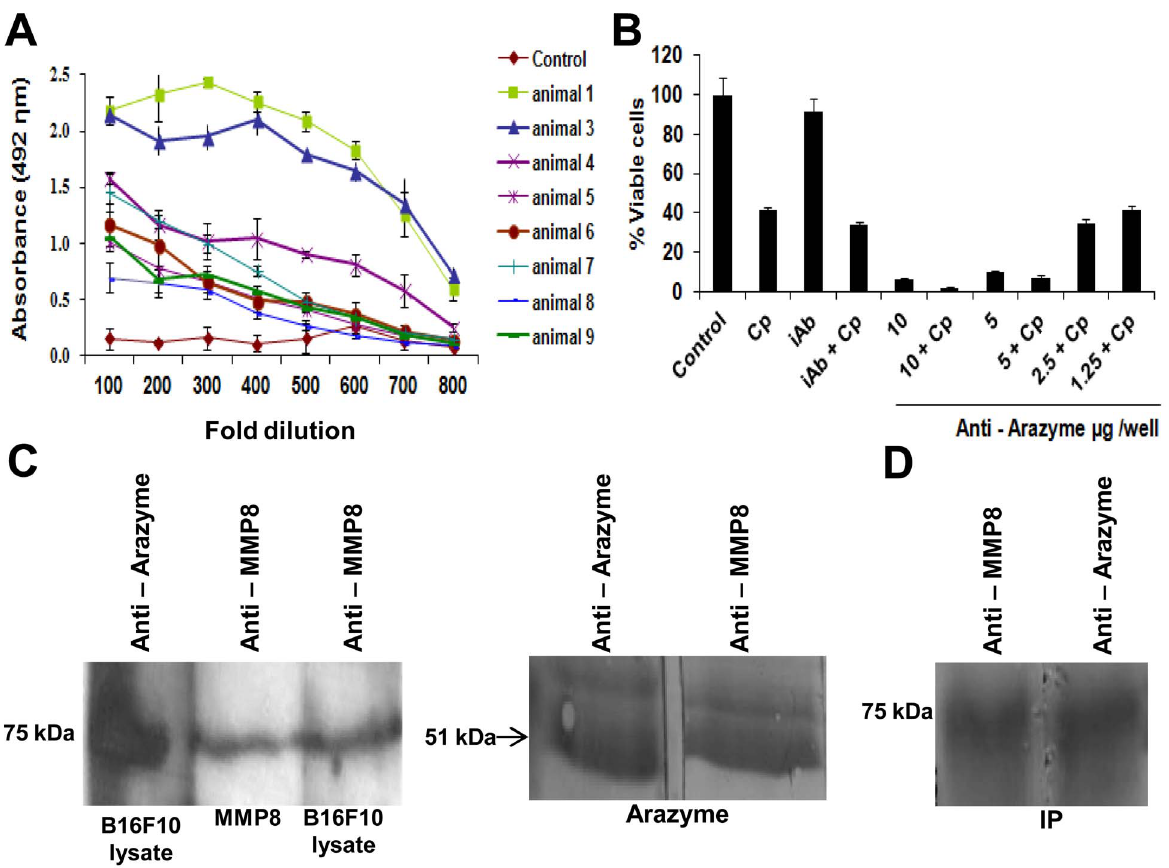
Figure 5. Arazyme treatment induces protease-specific antibodies that cross-react with matrix metallopeptidase 8 (MMP-8) and are cytotoxic to B16F10-Nex2 cells. (A) Serum (100 2 1 to 800 2 1 dilutions) from i.p arazyme-treated or untreated C57Bl/6 mice were analyzed by ELISA for arazyme-specific antibodies as described in materials and methods. Animals are represented individually. (B) In vitro cytotoxicity of anti-arazyme antibodies. Murine arazyme-specific protein G-purified IgG (1.25 to 10 m g/well) was incubated in the presence or absence of guinea-pig complement for 12 hours, viable cells were counted in presence of Trypan blue and compared to the untreated control. Cp, Complement and iAb, irrelevant antibody.*, p # 0.05. (C) B16F10-Nex2 cell extract, purified arazyme or recombinant MMP-8 were electrophoretically separated, blotted onto nitrocellulose membrane and revealed with rabbit anti-arazyme or monoclonal anti-MMP-8 antibodies. (D) B16F10-Nex2 cell extract was immunoprecipitated with Ab anti-arazyme, and the complex was collected with Sepharose-Protein-G beads. Western blotting of the precipitated